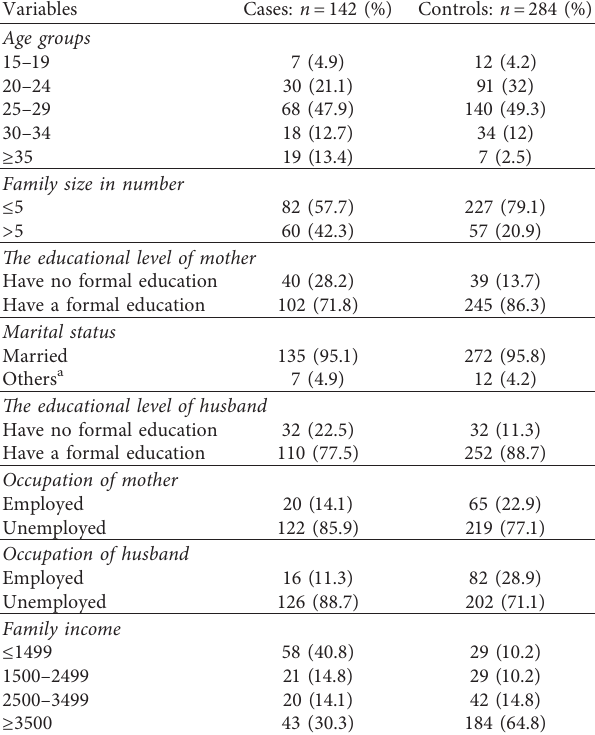
Table 1: Sociodemographic characteristics of pregnant women attending antenatal follow-up-care in public hospitals of the West Shewa zone, from February to April